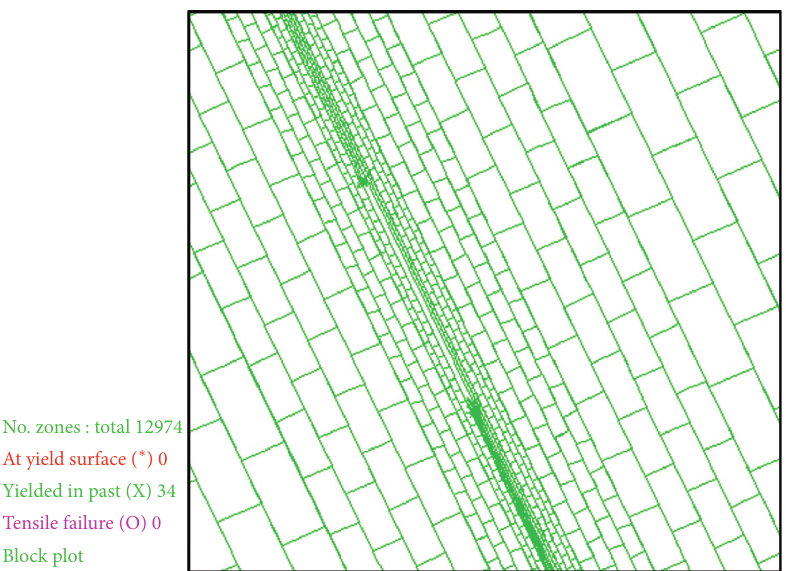
Figure 15: Surrounding rock failure pattern with 80m stope height (caving method).